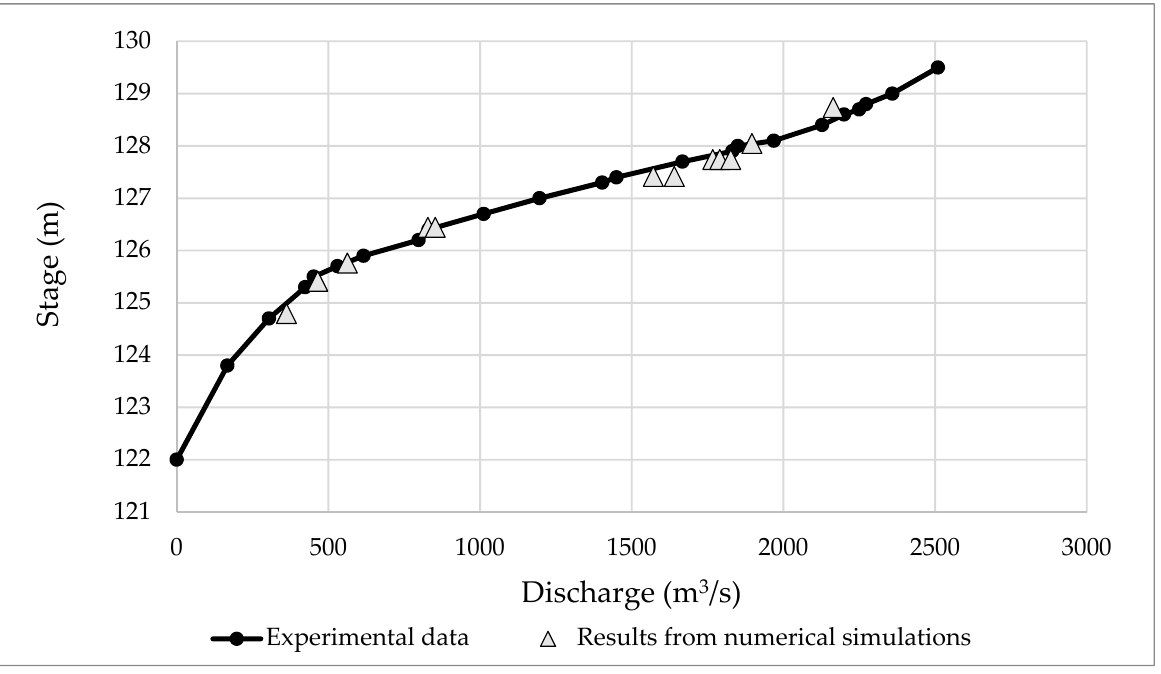
tion grid (10–20 mm, 8–16 mm, 5–12 mm). For all cases, the simulation continued until the